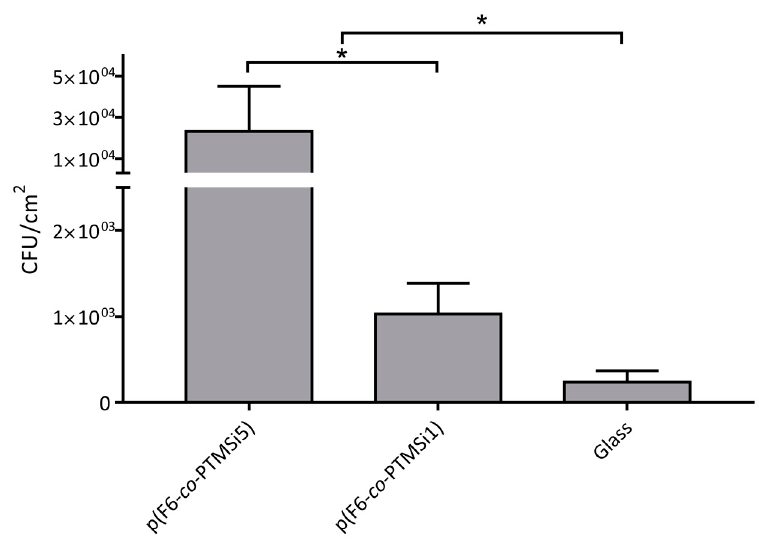
Figure 10. Adhesion of C. albicans to fluorinated films; * p ≤ 0.05 (second set of experiments).